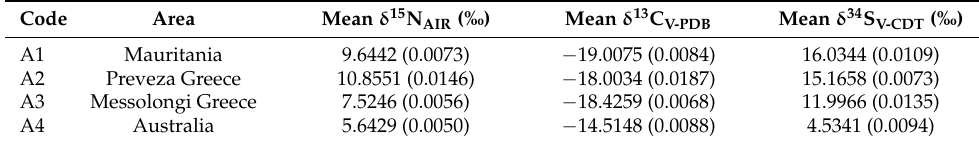
Table 2. Bottarga Analysis Results (mean δ values and standard error).